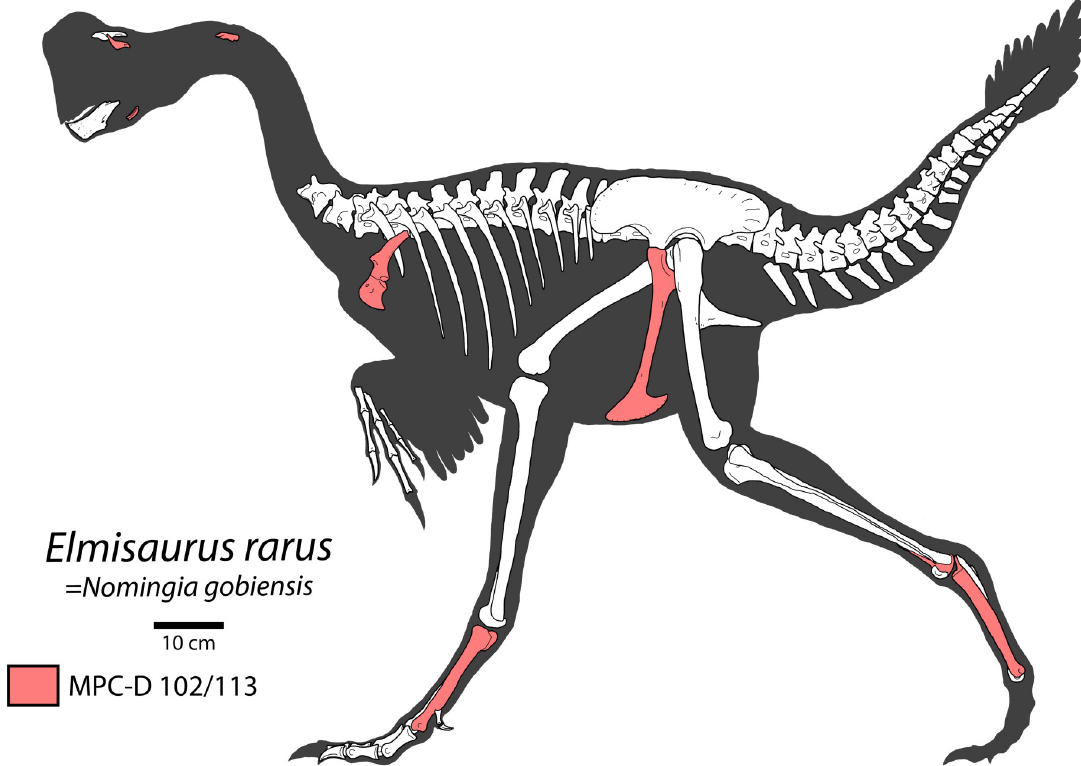
Fig 8. Skeletal reconstruction of Elmisaurus rarus . Skeletal reconstruction of known elements of Elmisaurus rarus , including material referred to “Nomingia gobiensis” . Elements highlighted in red are preserved in MPC-D 102/113.